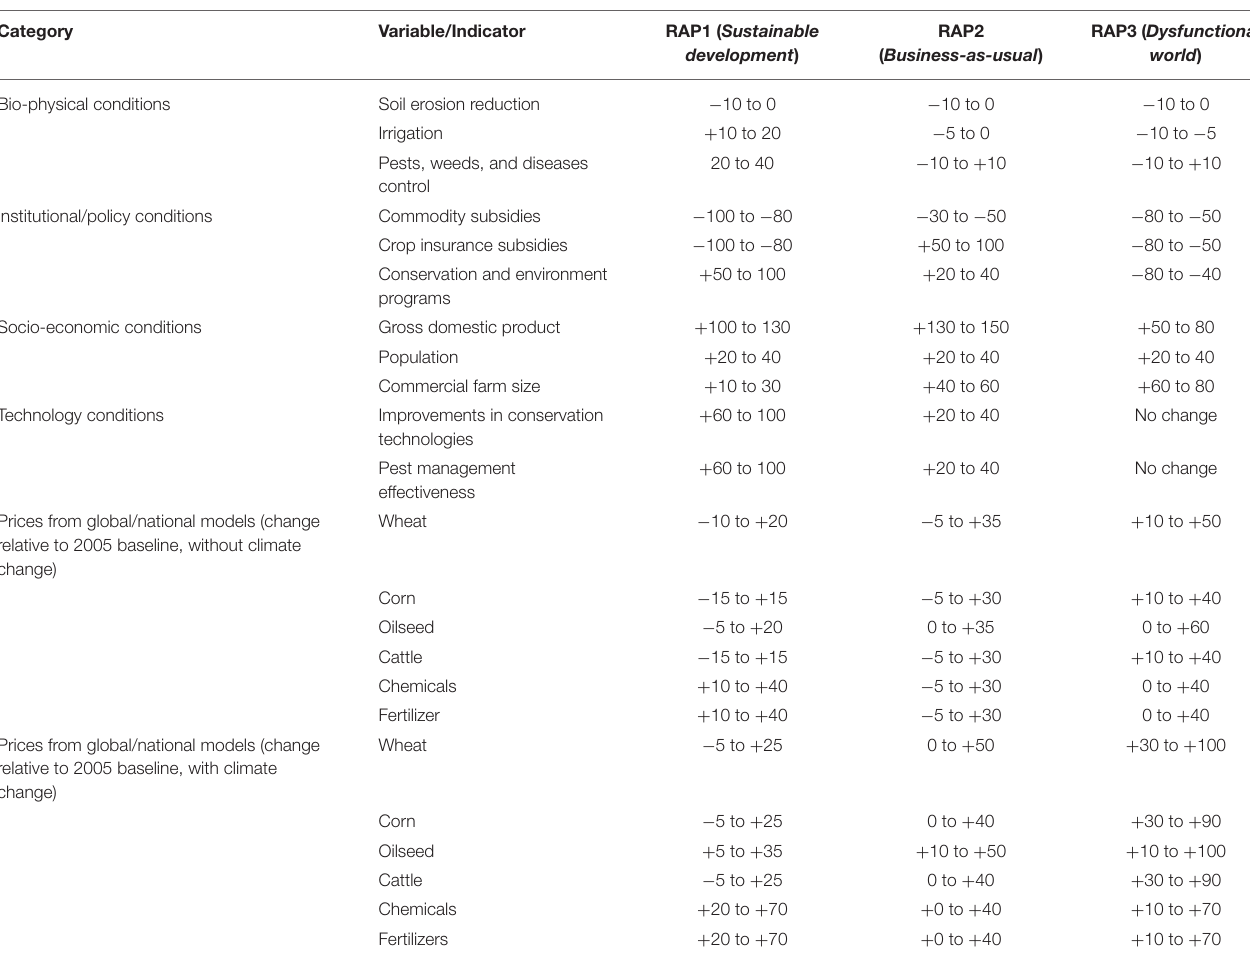
TABLE 2 | Ranges of variable changes for REACH RAPs